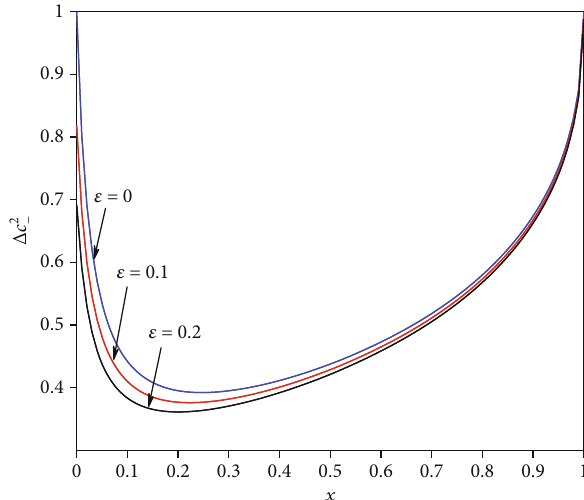
κ = 0 : 5 , A = 50 , and − versus x for